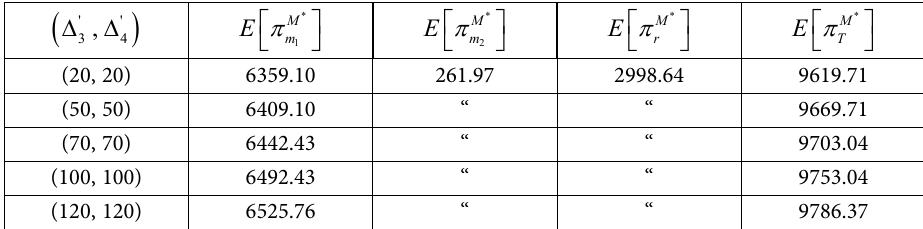
Table 8. Optimal values of the decision variables